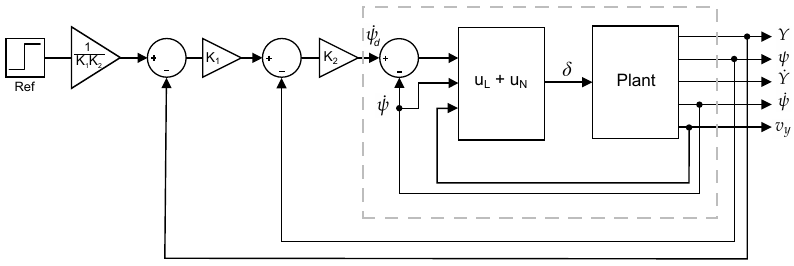
Figure 21. Schematic depiction of the CNF